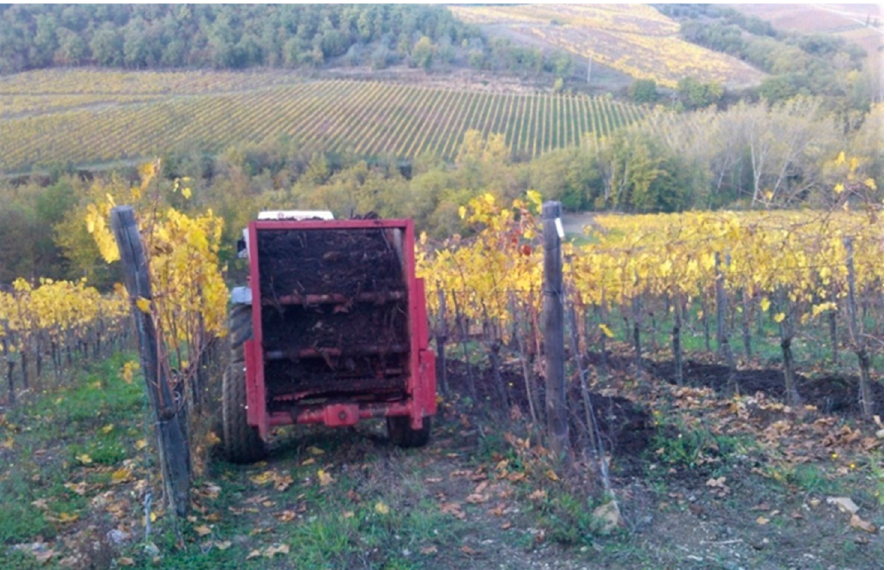
Figure 5. Compost produced in farm using manure, pruning residue, grape stalks, and marc, distributed by a manure spreader within a vineyard characterized by eroded and scarcely fertile soils.